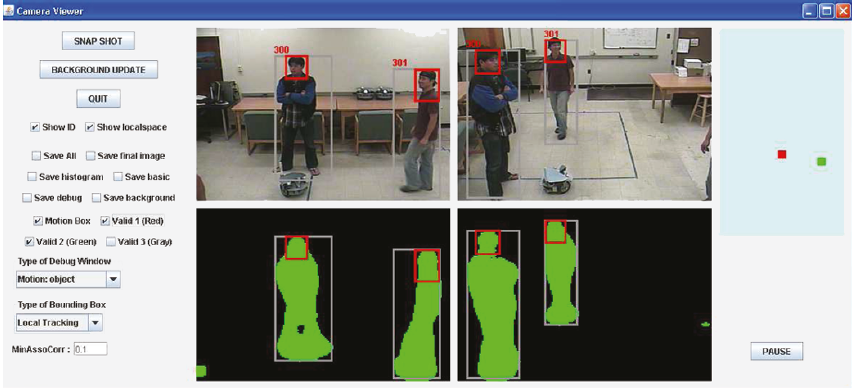
Figure 16: Visual sensors-based tracking demo: two visual sensors simultaneously detect, identify, and localize multiple